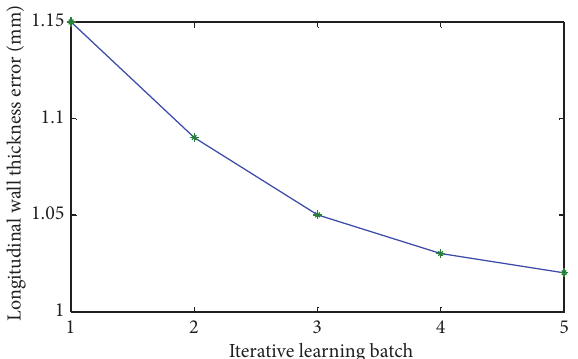
Figure 6: Scheme of ILC based on OSELM-RPLS.